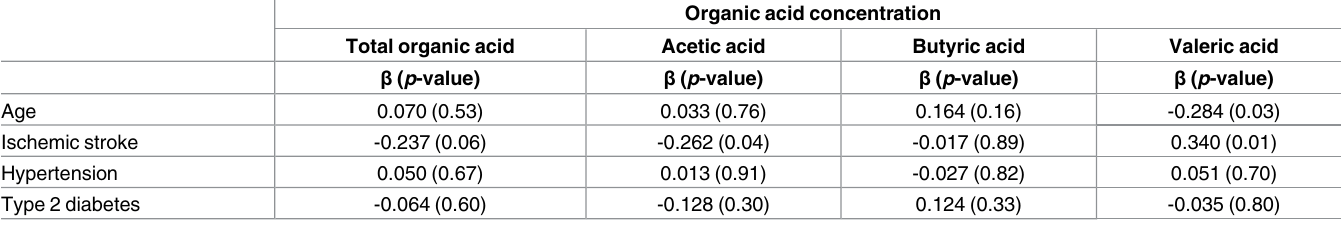
Table 6. Multivariable linear regression analysis to identify contributors to organic acid